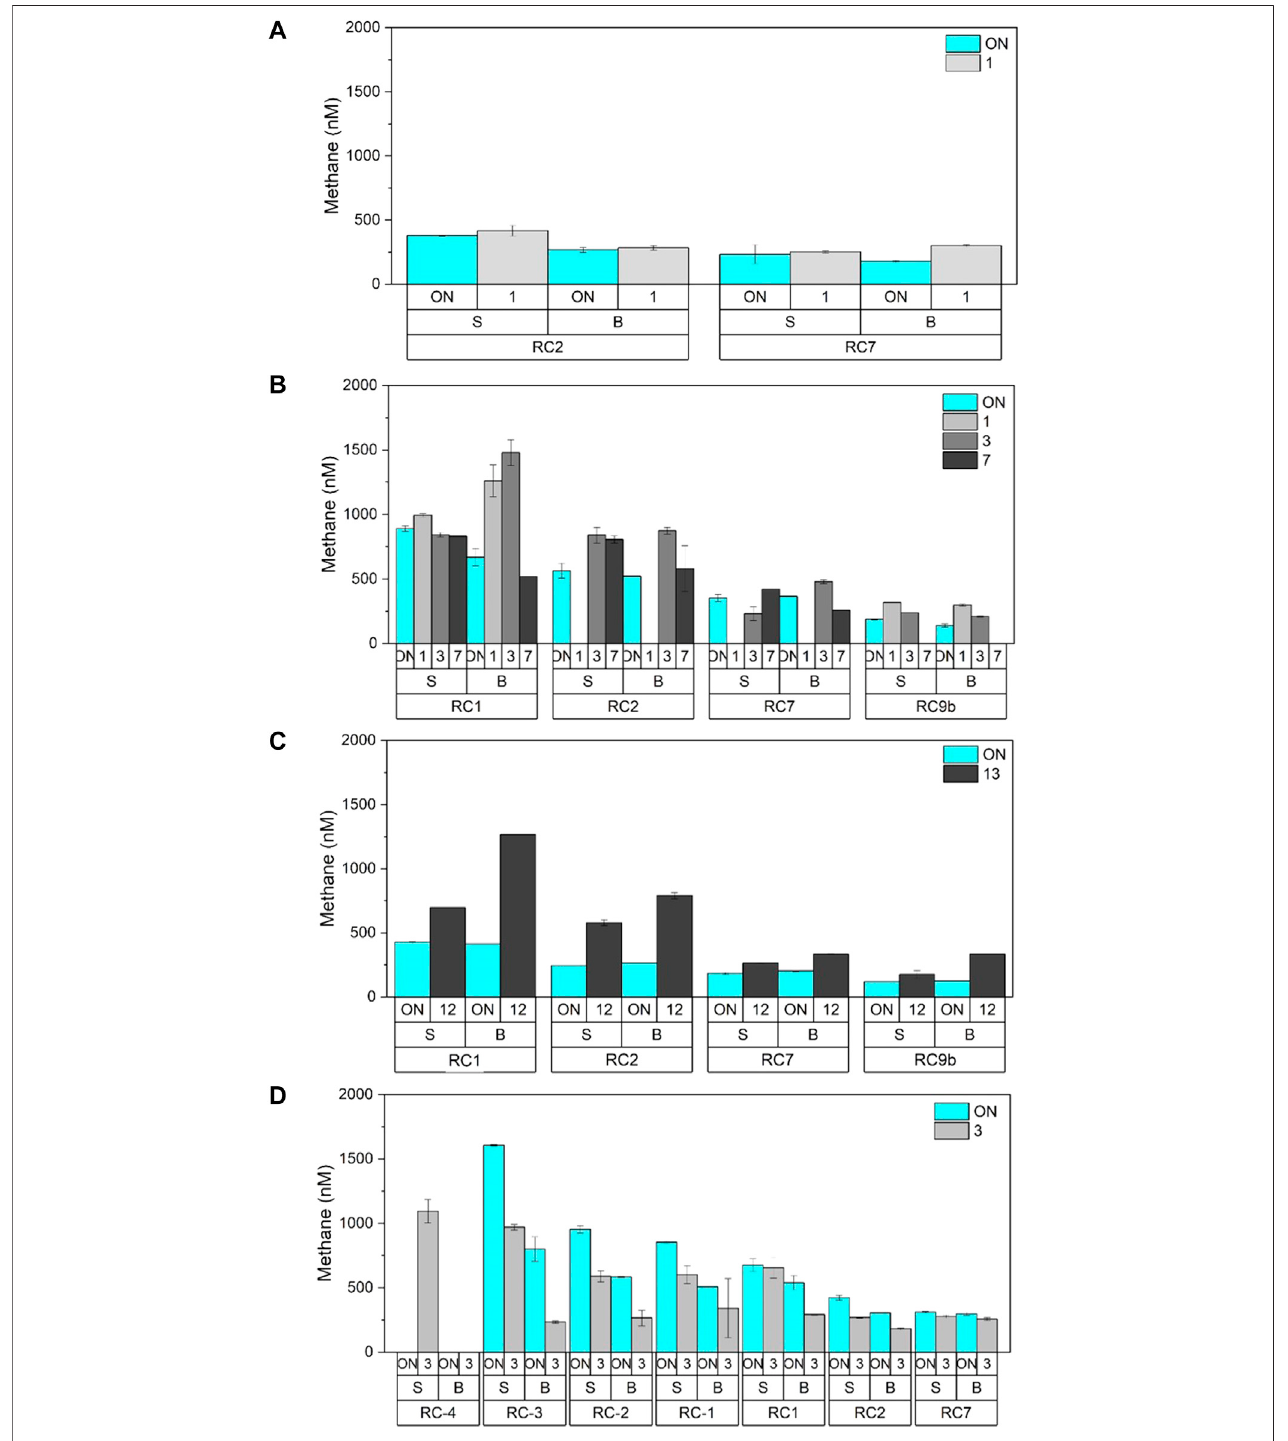
FIGURE 4 | Methane concentrations (colored bars) in surface (S) and bottom (B) water at all stations in (A) 2016, (B) 2018, (C) 2019, and (D) 2021. All blue colors represent the “ ON ” situation, and the gradients in gray color represent the number of days after aerators were turned off, which are described in each panel. Error bars represent standard error on replicate samples collected.